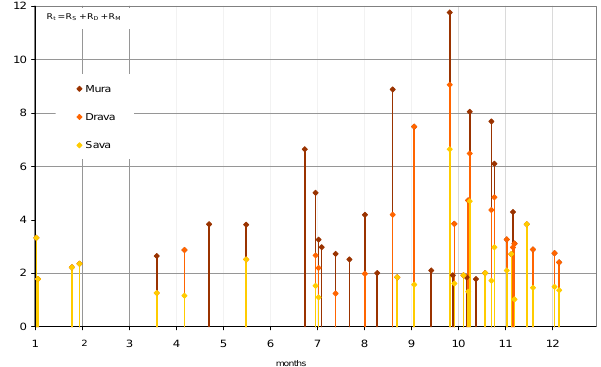
Fig. 2. Annual distribution of extreme runoff events within the study catchments. The height of the whole column represents the magnitude of the event R t within all three catchments which are distinguished by the